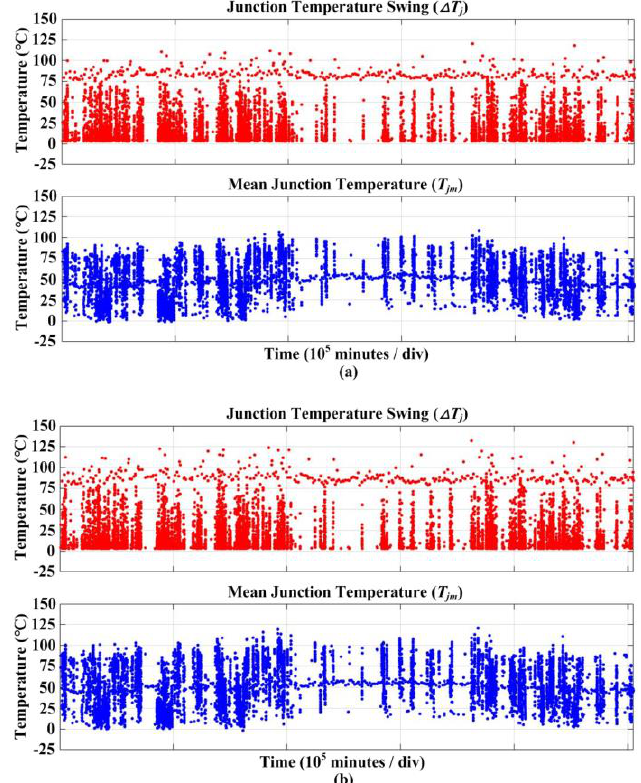
Figure 12. Junction temperature swing and mean junction temperature extracted from the junction temperature profiles by the Rainflow counting method: ( a ) outer IGBTs of the NPC inverter; ( b ) half-bridge IGBTs of the T-type inverter.